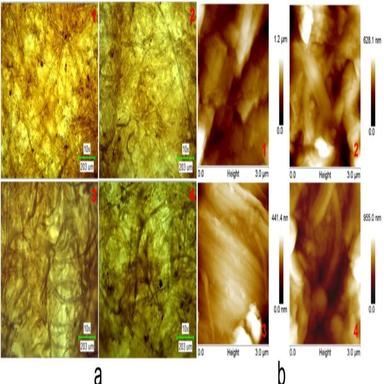
Microscopical analysis of the samples: (a) optical microscopy of samples 1–4; (b) atomic force microscopy of samples 1–4.